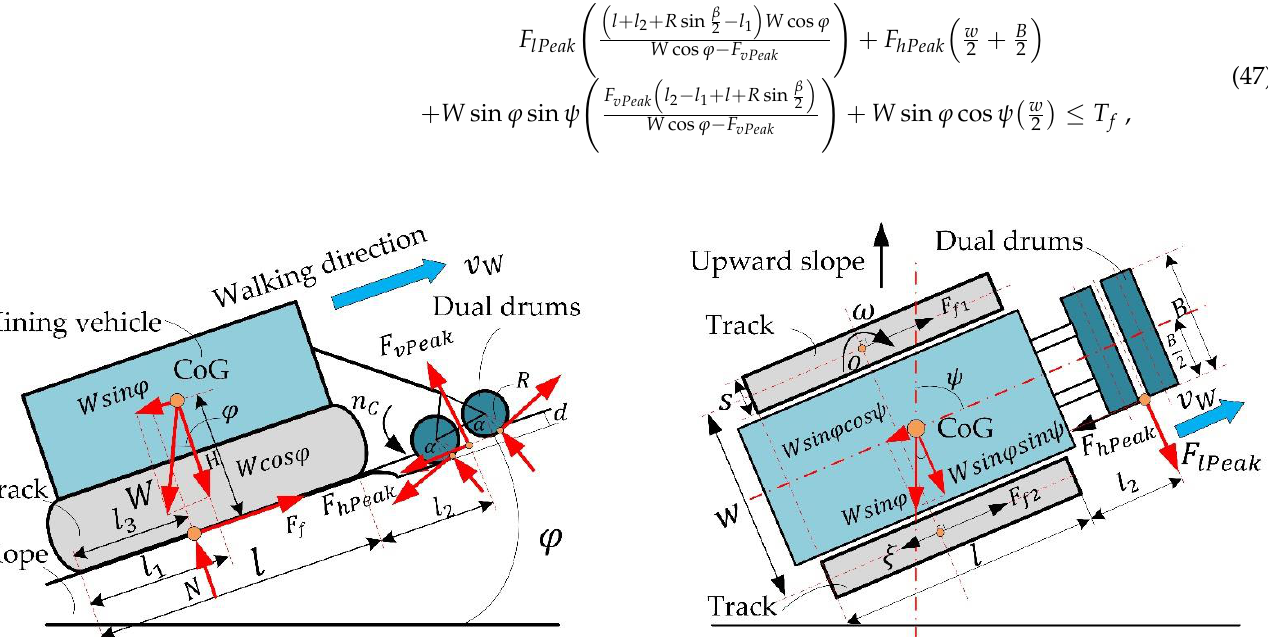
Figure 7. Anti-skid steering stability diagram of the mining vehicle with the dual-drum head.